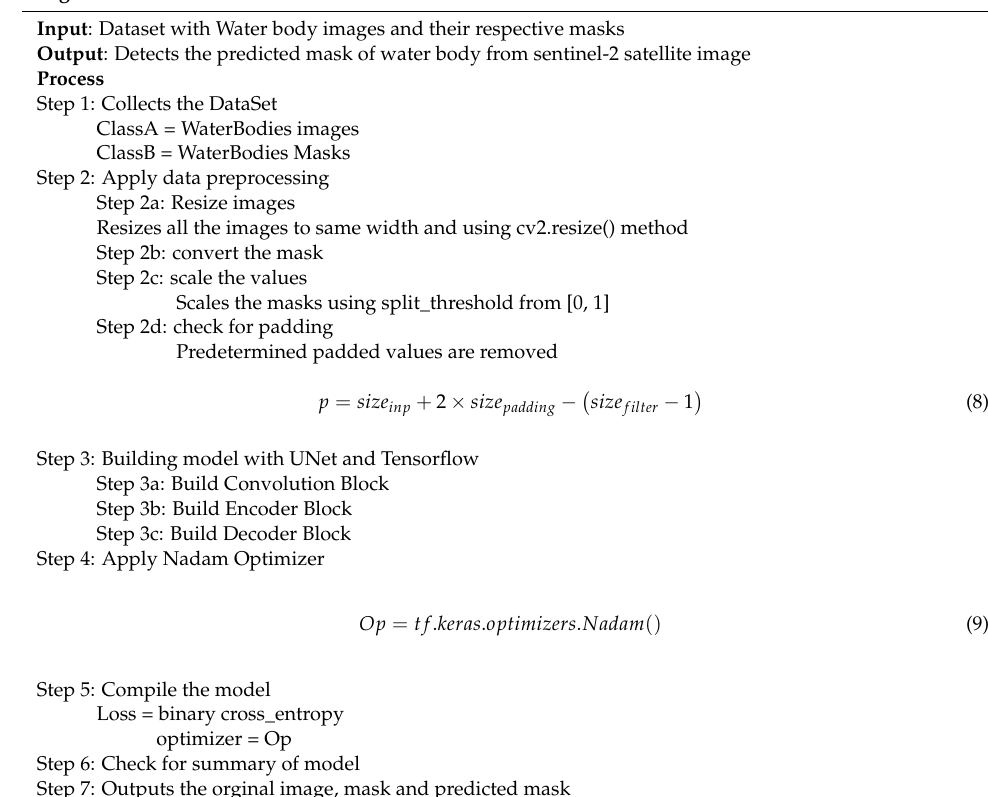
Algorithm 1: Water Bodies Detection